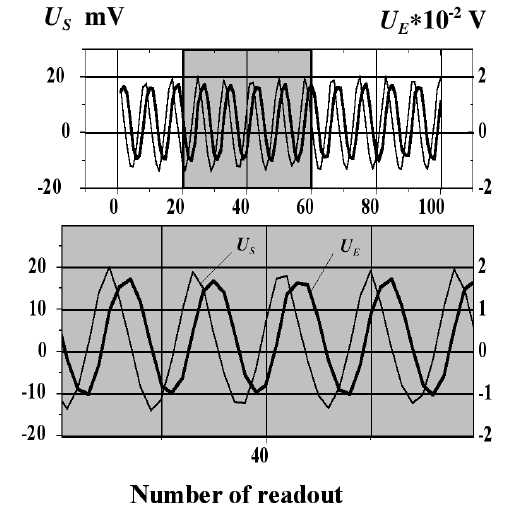
Fig. 9a. MSO of the second type. Change in self- oscillations after sample damping. Measurements were executed with 30-40 s intervals: dry sample, electric ( U E ) and acoustic ( U S ) signals.